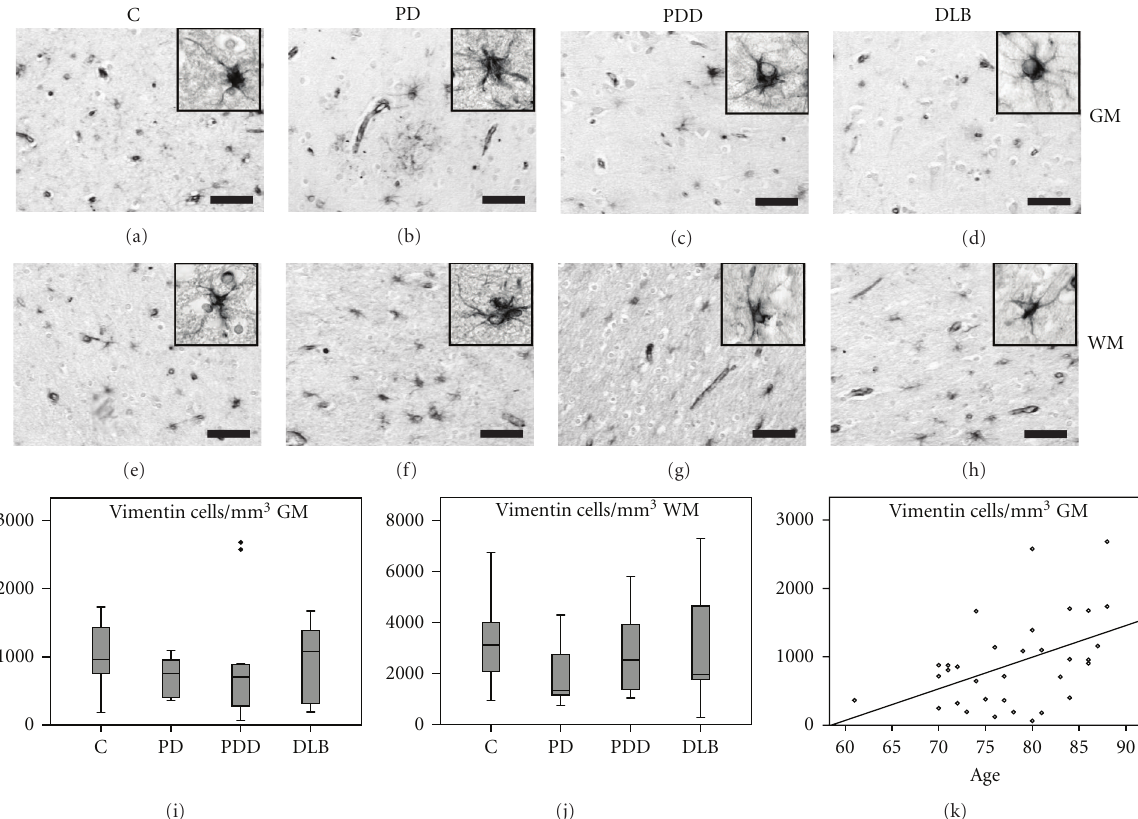
Figure 2: Vimentin immunoreactivity in the human frontal cortex. (a–h) examples of vimentin immunoreactivity in grey (a–d) and white matter (e–h) of a 71-year-old male control (C) donor (NBB 2002-087; a, e), a 86-year-old male Parkinson’s disease (PD) patient (NBB 2001- 122; b, f), a 75-year-old female Parkinson’s disease with dementia (PDD) patient (NBB 2003-059; c, g), and 72-year-old male dementia with Lewy bodies (DLB) patient (2002-017; d, h). (i-j) Boxplot of the quantification of vimentin staining in grey (i) and white matter (j) of 8 C, 6 PD, 11 PDD, and 9 DLB cases. Outliers are shown as dots. (k) correlation of vimentin expression in the grey matter with age of the 34 donors. GM: grey matter; WM: white matter; inserts show higher magnification images of the same patients. Scale bars represent 50 μ m for the lower magnification and 20 μ m for the higher magnification